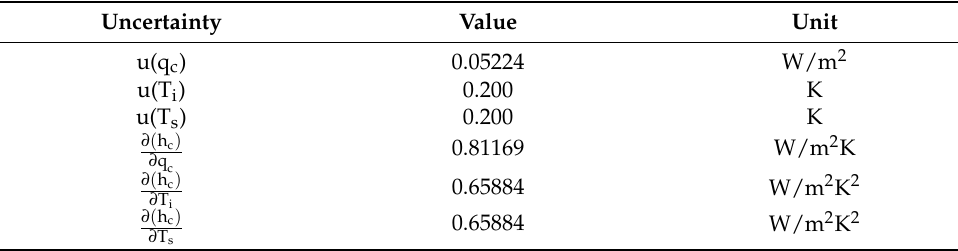
Table 3. Uncertainties in CHTC measurement.